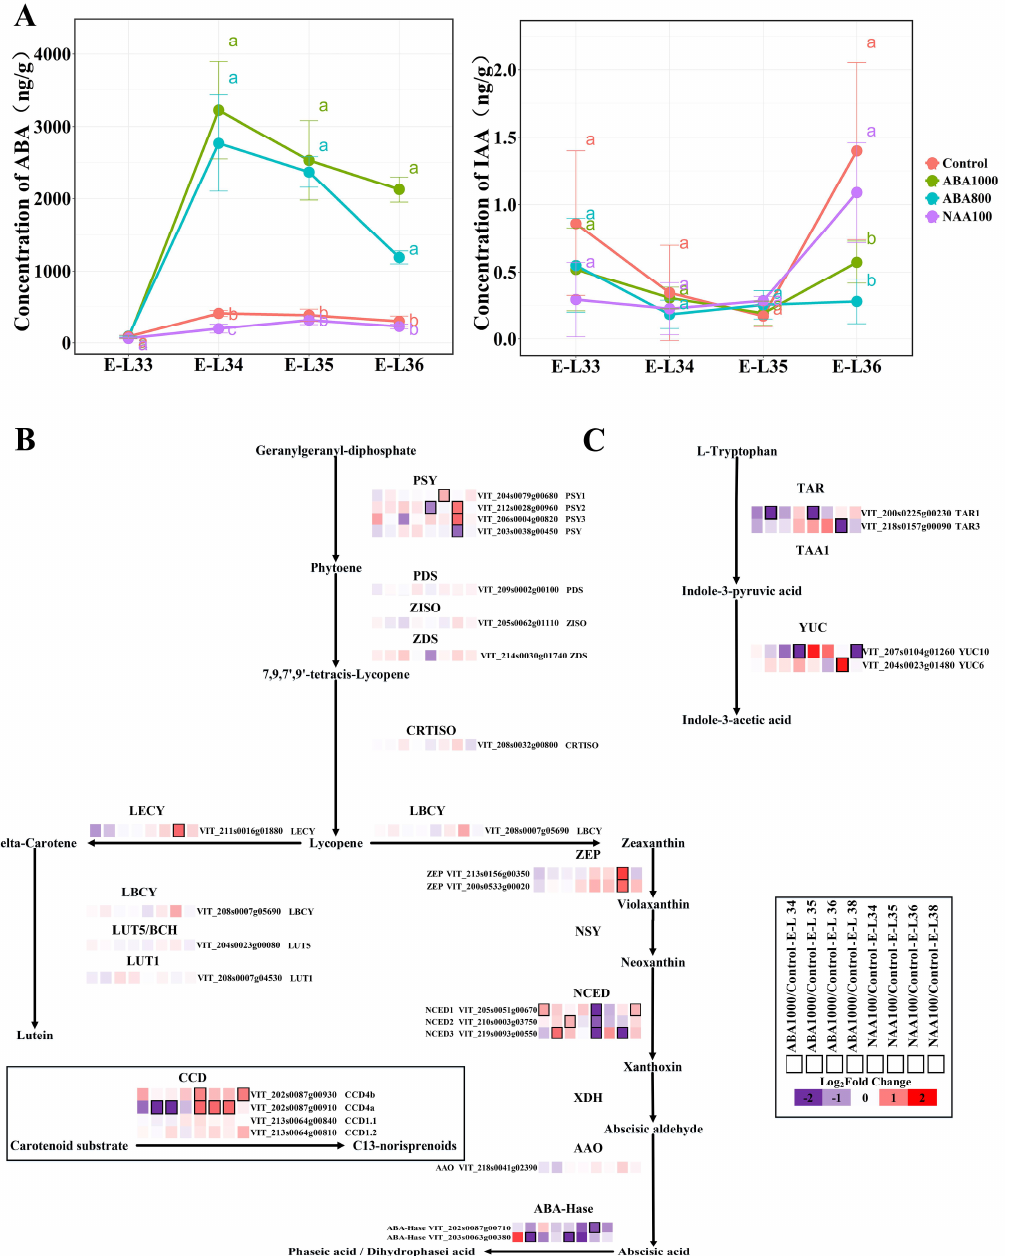
Figure 2. Effects of ABA and NAA on hormone accumulation and related gene expression during berry development and ripening. ( A ) Concentrations of endogenous ABA and indole-3-acetic acid protein (IAA) from E-L 33 to E-L 36 stage. Bars represent ± SE and different letters indicate significant differences ( p = 0.05). ( B ) Pathways analysis of genes involved in ABA and norisoprenoid biosynthesis. Purple and red boxes indicate downregulated and upregulated genes, the colors of the boxes represent the intensity of the expression fold changes (log2). Genes with significant expression changes compared with the control groups in each developmental stage are indicated by bold margins. PSY, phytoene synthase; PDS, 15-cis-phytoene desaturase; ZISO, zeta-carotene isomerase; ZDS, zeta-carotene desaturase; CRTISO, prolycopene isomerase; LECY, lycopene epsilon-cyclase; LBCY, lycopene beta-cyclase; LUT5, beta-ring hydroxylase; BCH, beta-carotene 3-hydroxylase; LUT1, carotene epsilon-monooxygenase; ZEP, zeaxanthin epoxidase; NSY, neoxanthin synthase; NCED, 9-cis-epoxycarotenoid dioxygenase; XDH, xanthoxin dehydrogenase; AAO, abscisic-aldehyde oxidase; CCD, carotenoid cleavage dioxygenase. ( C ) Pathways analysis of genes involved in auxin biosynthesis. TAR, tryptophan aminotransferase related 1; TAA1, tryptophan aminotransferase arabidopsis1; YUC, YUC flavin monooxygenase.